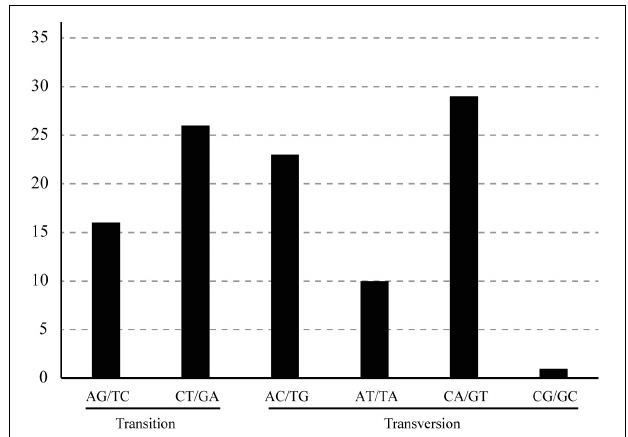
FIGURE 5 | Patterns of SNPs among the B. sinensis samples. Nucleotide substitutions were divided into six types as indicated by the six non-strand-specific base-substitution types (i.e., numbers of G to A and C to T sites for each respective set of associated mutation